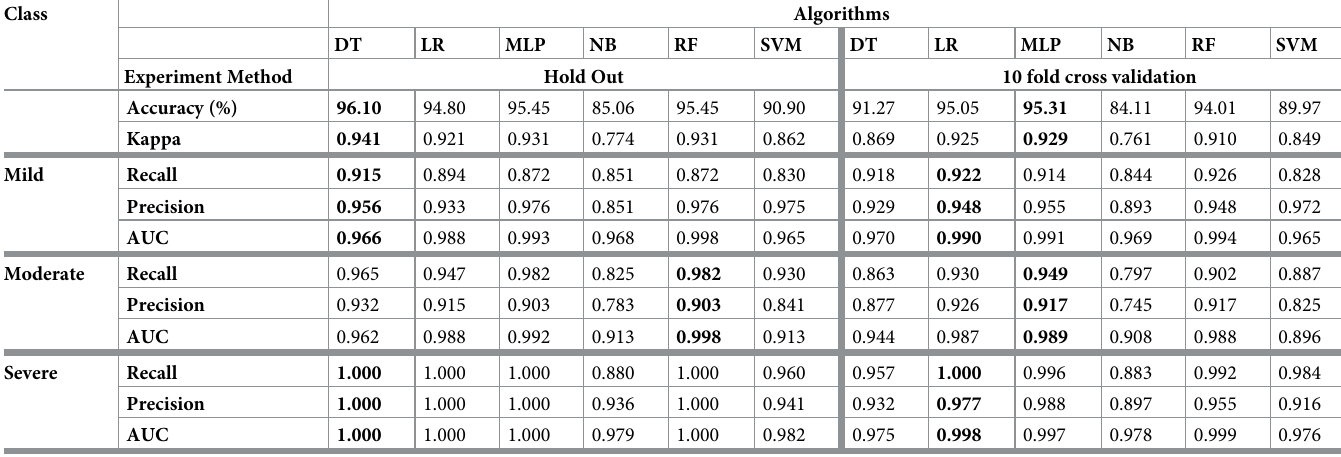
dominated with recall values of 100 percent and 90.2 percent in the case of hold-out and 10-fold cross validation methods and AUC values of 98.5 and 97.6% in the case of hold-out and 10-fold cross validation methods. Severe class being the critical stage of the Anemia dis- ease and due to the low quantity of samples of that data, it has yielded poor results. The results obtained using the feature selected dataset in Table 6 show that in the case of Mild class, Decision Tree had given the best result with recall value of 91.5 percent, precision value of 95.6 percent and AUC value of 96.6 percent when hold-out method is used. Whereas in the case of 10-fold cross validation method, LR has given the recall value of 92.2 percent, precision value of 94.8 percent and AUC value of 99.0 percent. For the Moderate class, Ran- dom Forest had given the best result with recall value of 98.2 percent, precision value of 90.3 Table 6. Summary of the results obtained using the dataset2 (feature